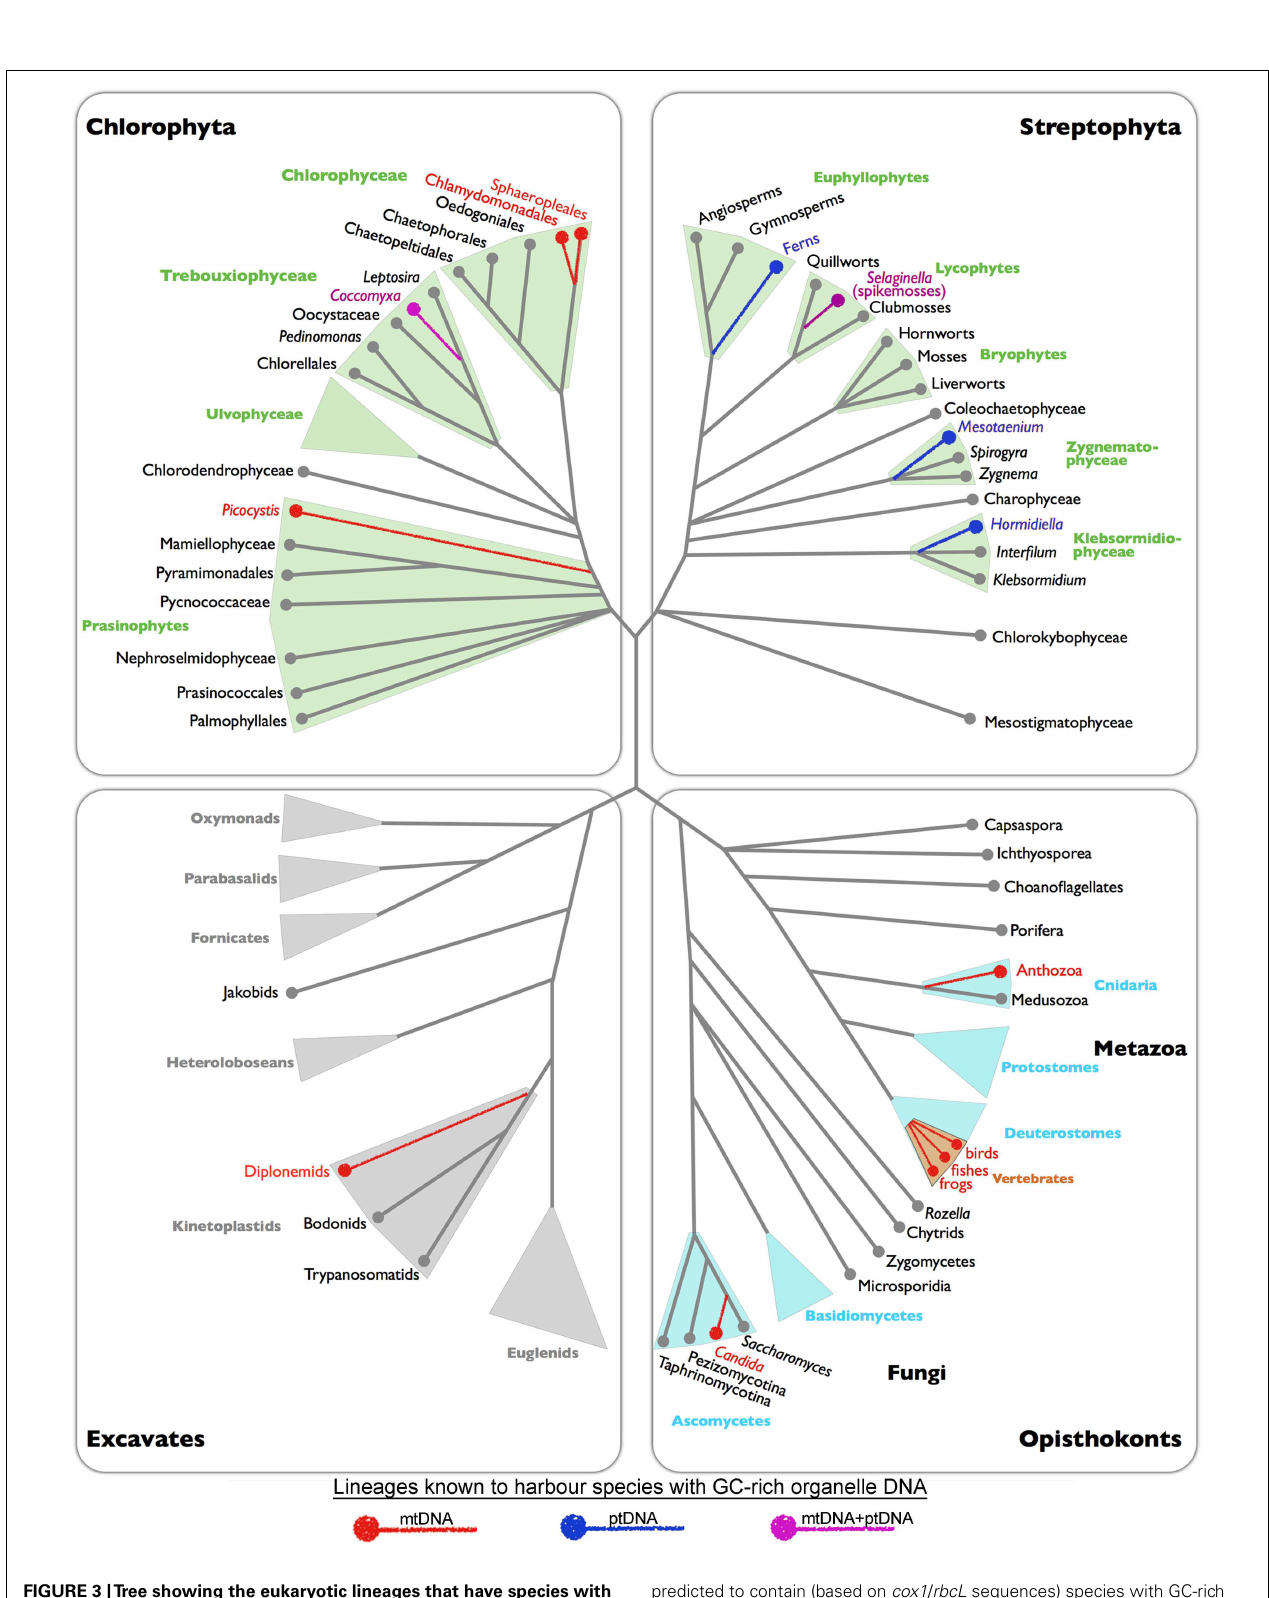
FIGURE 3 |Tree showing the eukaryotic lineages that have species with GC-rich organelle genomes. Colored branches represent lineages that are known to contain (based on complete organelle genome sequence data) or